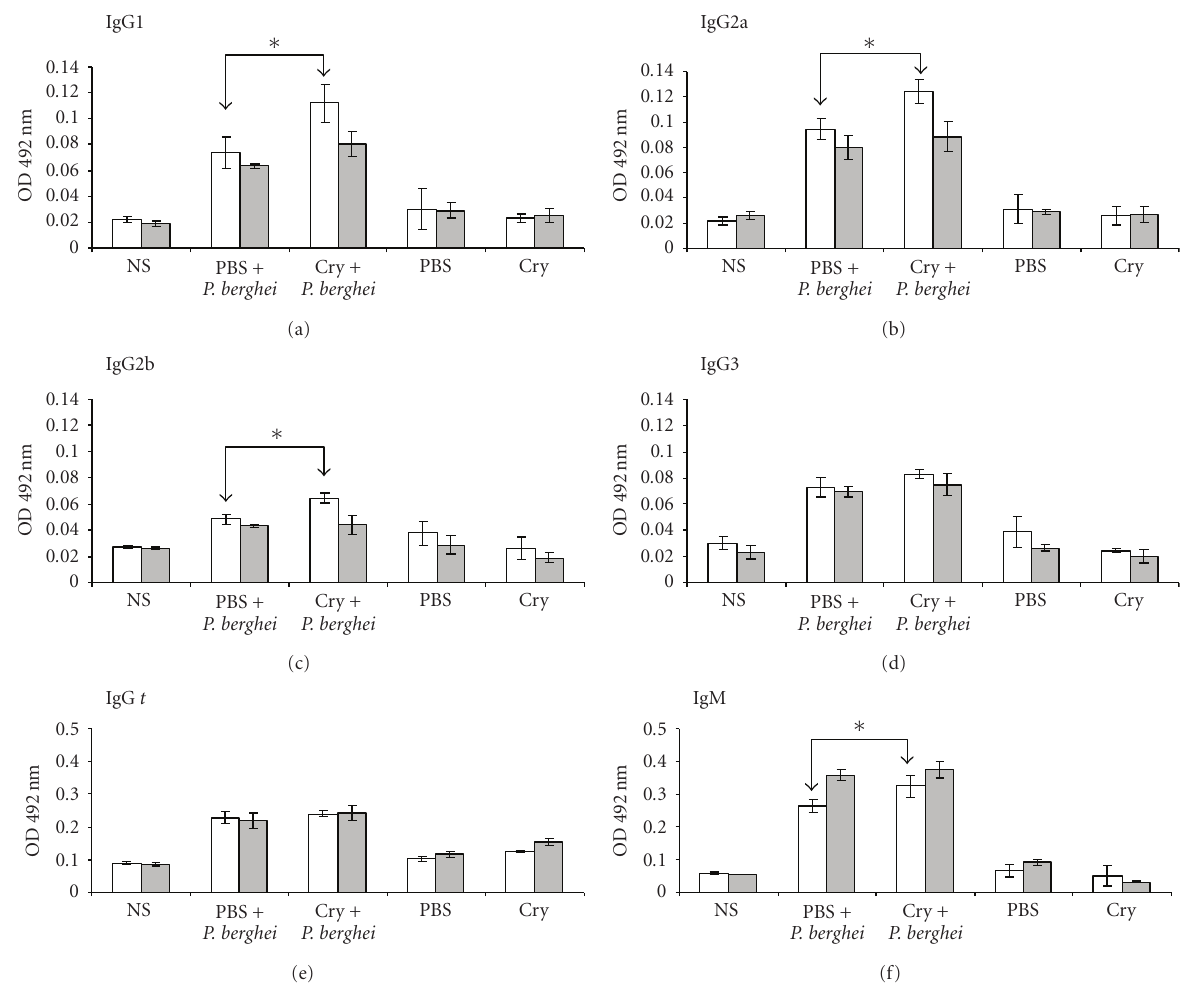
Figure 5: Parasite-specific antibody responses in mice treated with Cry1Ac and infected with P. berghei ANKA. Mice were treated with Cry1Ac protoxin or PBS as described previously and were infected with P. berghei ANKA. At days 4 (white bars) and 8 (grey bars) PI, the sera of three mice from each group were collected and measured by ELISA for antibody levels. The results are expressed as the mean OD value ± SD ( n = 3) . Control absorbance values were provided by normal mouse serum (NS) obtained from age- and sex-matched CBA/Ca mice. Data are representative of two separate experiments. Asterisks indicate statistically significant di ff erences between the indicated groups.